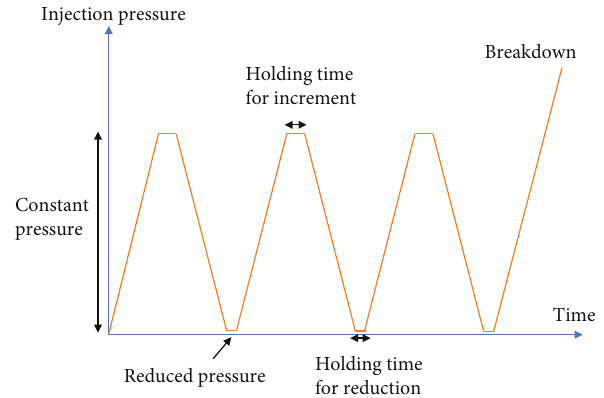
Figure 6: The vertical fracture created along the axial direction in a specimen for the fi rst